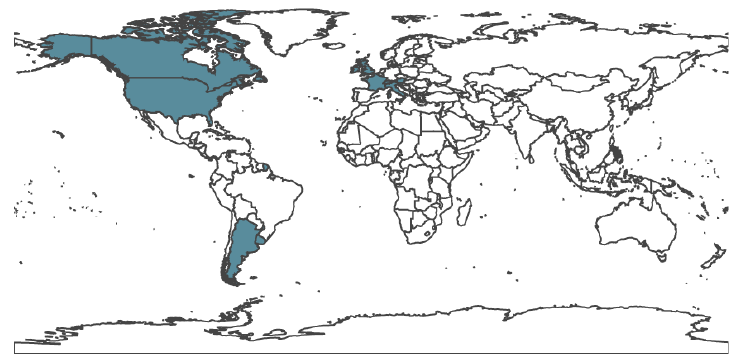
Figure 2. Countries with relatively reliable COVID-19 case counts and which achieved high resistance to the virus (either by vaccination or by prior infections) by July 2021 are colored in teal. These 14 countries were used in our analysis.